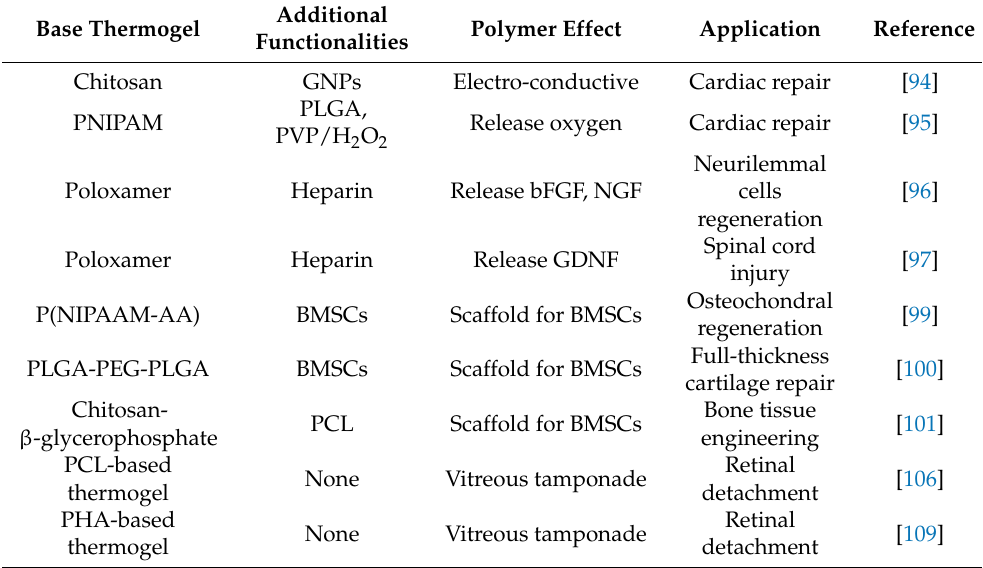
Figure 6. ( a ) Synthesis procedure of the EPC copolymer. ( b ) Schematic diagram illustrating thermogel use as endotamponade. ( c ) EPC vitreous-like body was formed that is similar to native vitreous. ( d , e ) Characterization of the vitreous-like body, showing ( d ) number of identified proteins which overlapped between native and EPC reformed vitreous and ( e ) ranked protein abundance across the native vitreous, reformed EPC, and BSS control proteome. Copyright © 2019 Springer Nature [106]. Table 3. Thermogel systems for tissue